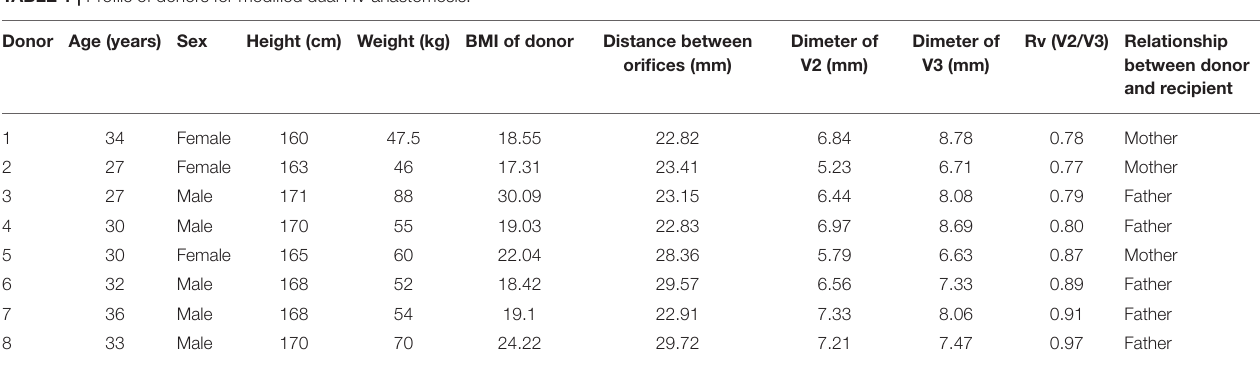
TABLE 1 | Profile of donors for modified dual HV